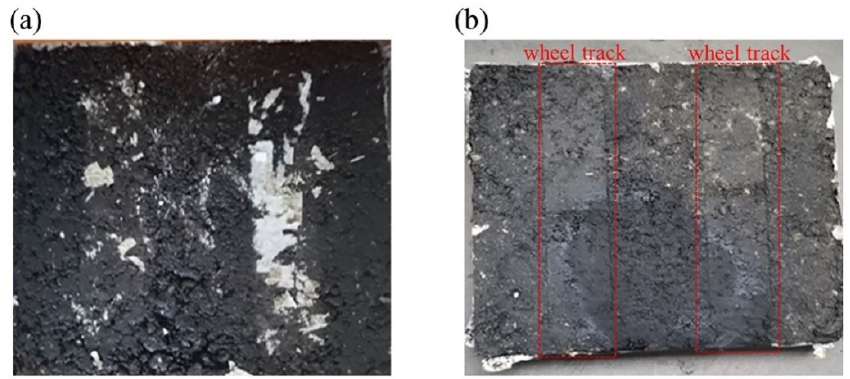
Figure 3. The test samples ( a ) prior to and ( b ) post rutting test.